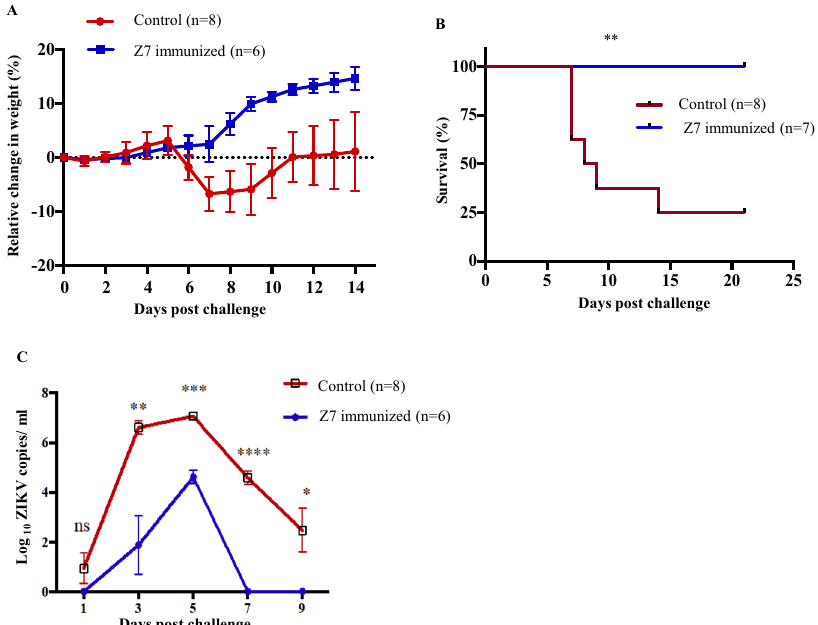
Fig. 7 Z7 immunized plasma protects Ifnar1 − / − mice from ZIKV infection. Five-week-old Ifnar1 − / − mice were infused with 100 µl of plasma collected from Z7 (G10) immunized or control mice via retro-orbital injection. After 24 h, the mice were challenged with 1 × 10 5 PFU of ZIKV (strain PRVABC59) via footpad inoculation. A Relative changes in body weight. B Survival curves. Mice were monitored daily for 21 days to determine the survival. C Viremia. Mice were bled every-alternate day from D1 to D9 p.i., and viremia was determinized by measuring the ZIKV E copies by qRT-PCR. Data were compared with a log-rank test ( B ), a two-tailed Student ’ s t -test ( C ) and presented as mean ± s.e.m. with * p < 0.05, ** p < 0.01, *** p < 0.001, and **** p <